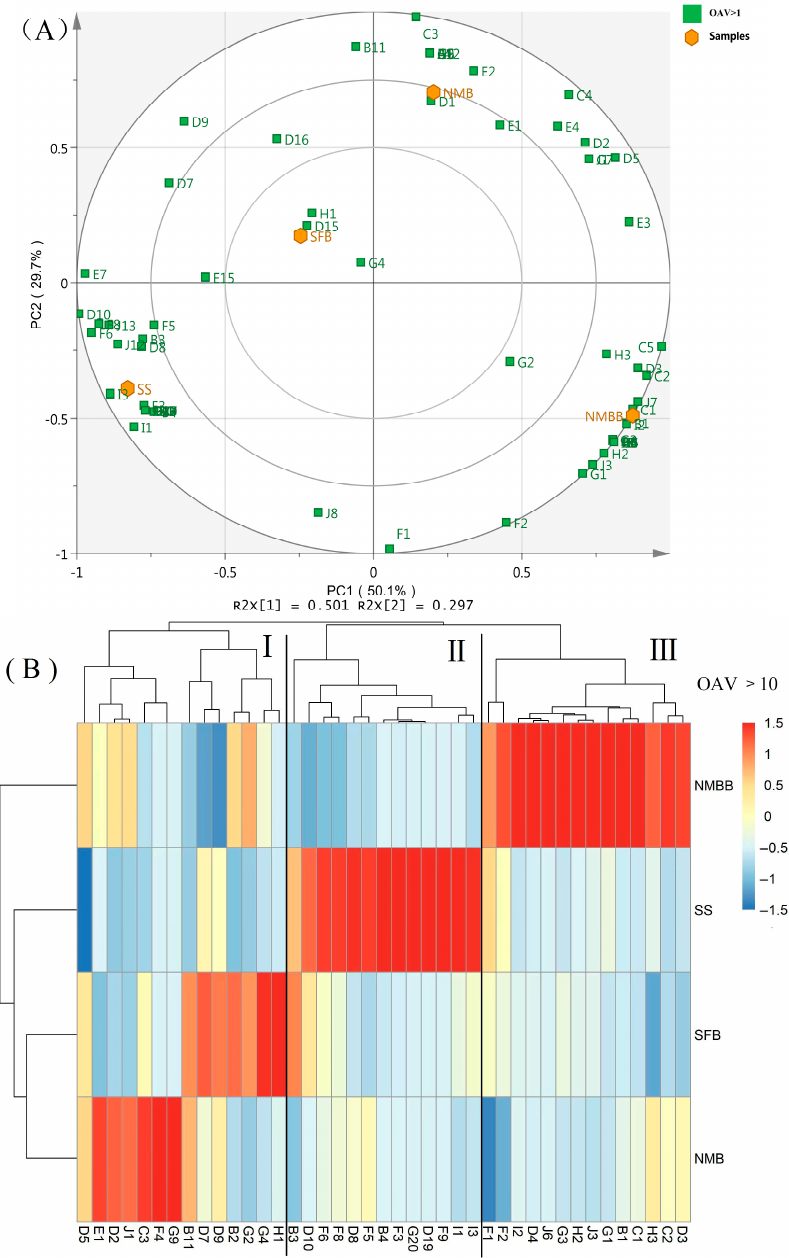
Figure 2. Biplot of principal component analysis in four samples (OAV > 1) ( A ). Gallery plot ( B ), clustering results of steamed soybean (SS), soybean fermented by BZ25 (SFB), natto made by GUTU09 (NMB), and natto made by two mixed strains (NMBB) (OAV > 10). Each rectangle represents a volatile compound. Color represents the OAV of the compound, with blue and red indicating low and high, respectively. The higher the OAV of VOCs the darker color. A refers to amines; B refers to esters; C refers to pyrazines; D refers to ketones; E refers to acids; F refers to aldehydes; G refers to alcohols; H refers to aromatics; I refers to furans and J refers to others volatile compounds. Figure 2B shows hierarchical clustering and heat map visualization of volatile com- pounds of four samples in different treatments (OAV > 10). The gallery plot of four